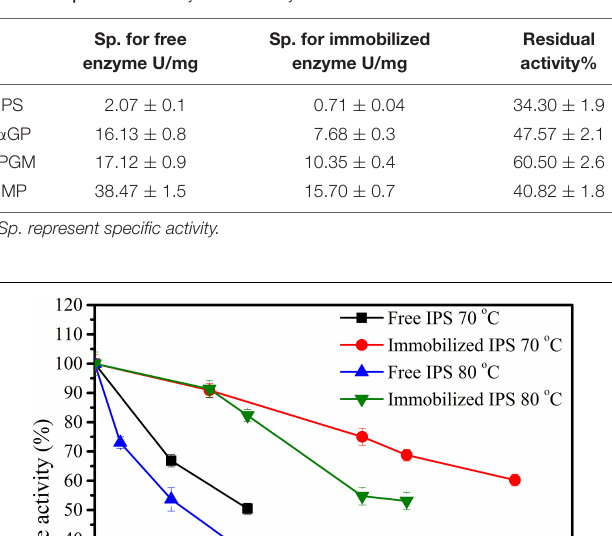
TABLE 2 | t 1 / 2 before and after immobilization at 70 ◦ C or 80 ◦ C.